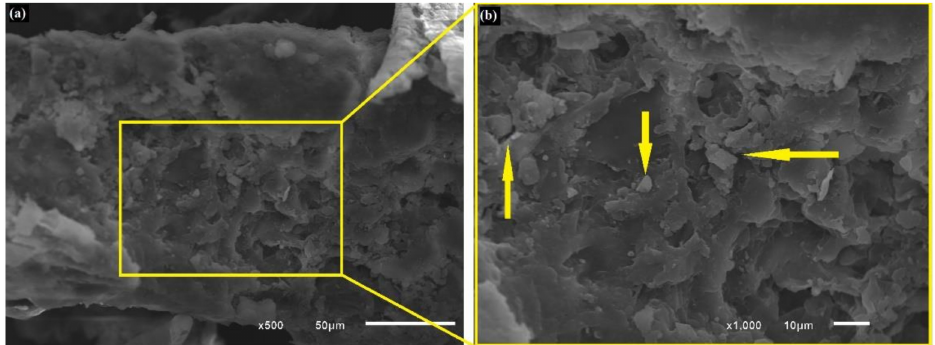
Figure 5. Photomicrographs of fresh in natura CHFW; ( a ) 500 × and ( b ) 1000 × .